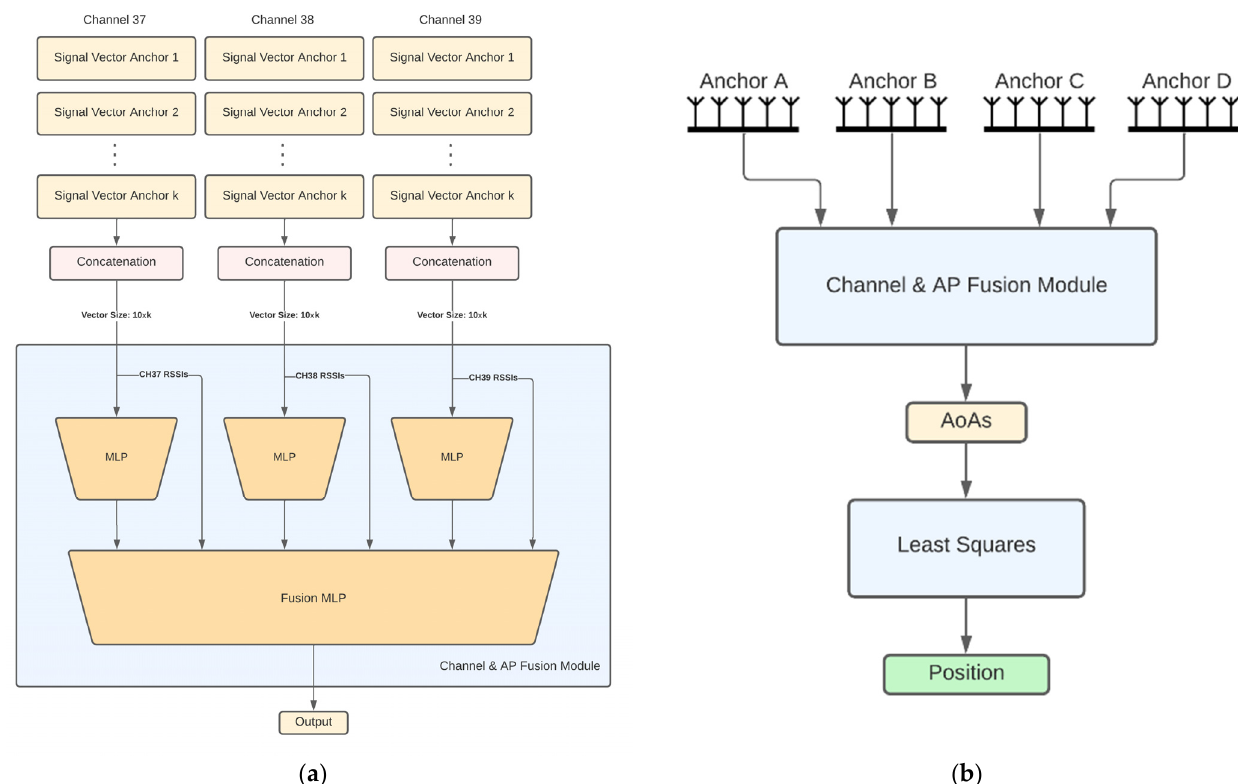
Figure 2. ( a ) Channel and AP fusion module; ( b ) Fully joint AP architecture.